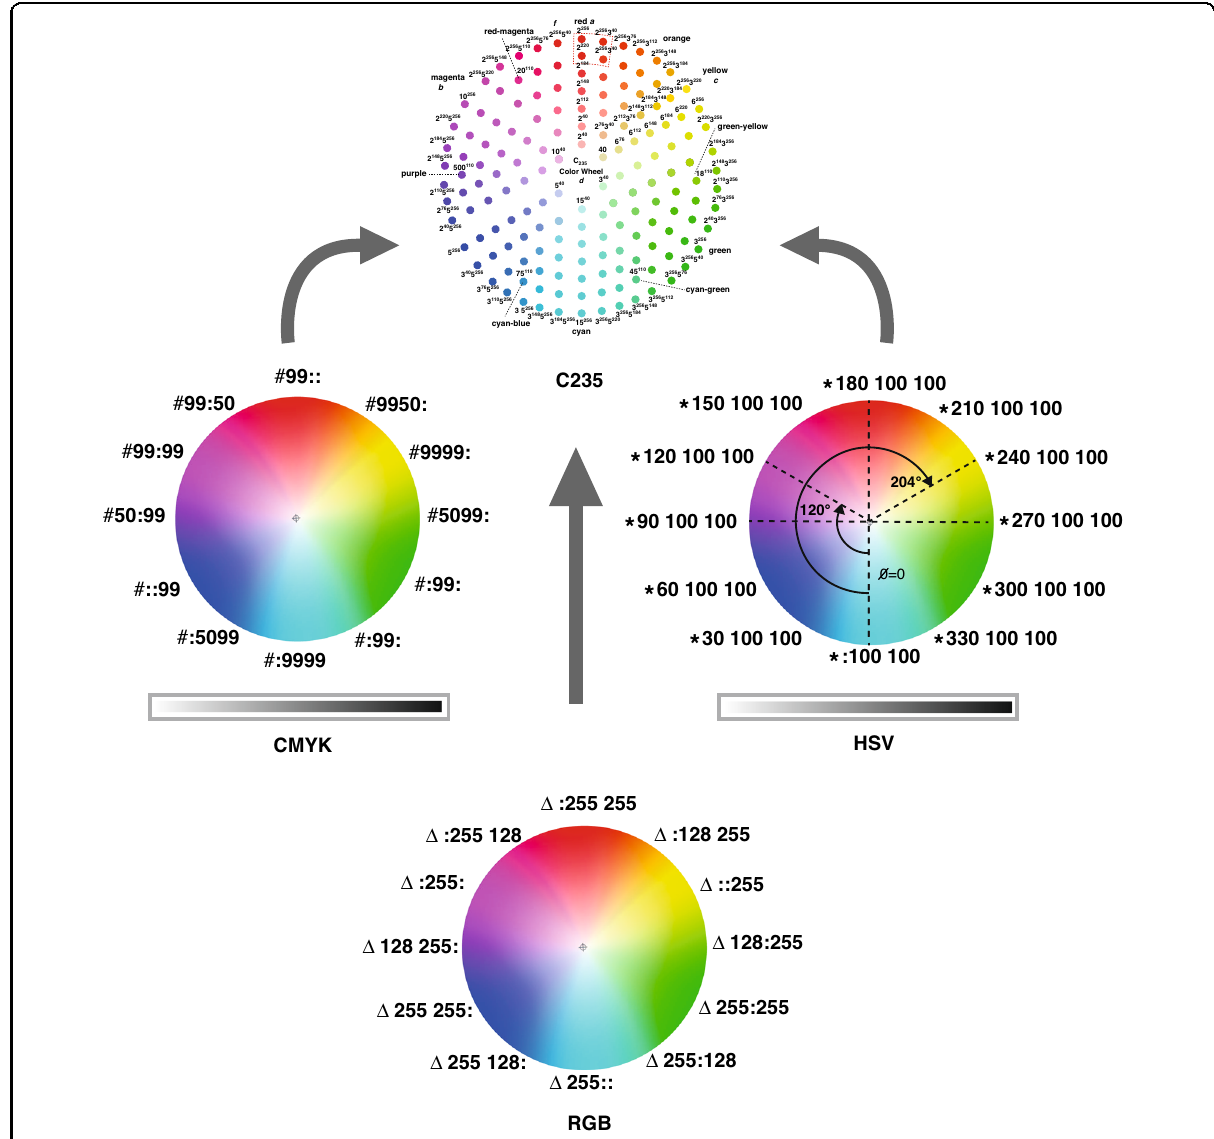
Fig. 2 C 235 wheel of unifying RGB, CMYK, and HSV. The compressed C 235 wheel uni fi es CMYK, RGB, and HSV color systems using a much smaller number of raw colors (key values) to represent all 256 3